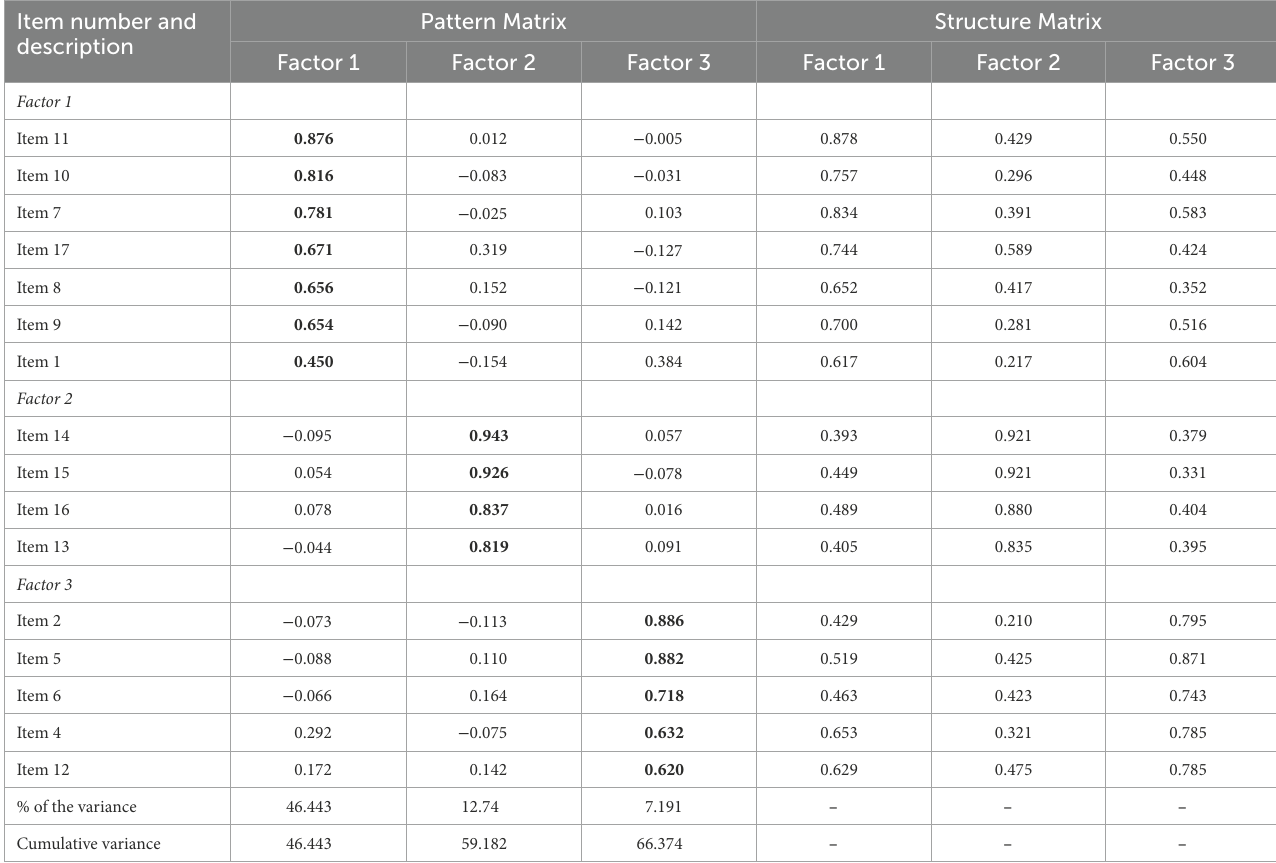
TABLE 3 The exploratory factor analysis results of the C-FFCS ( N = 170). Item number and